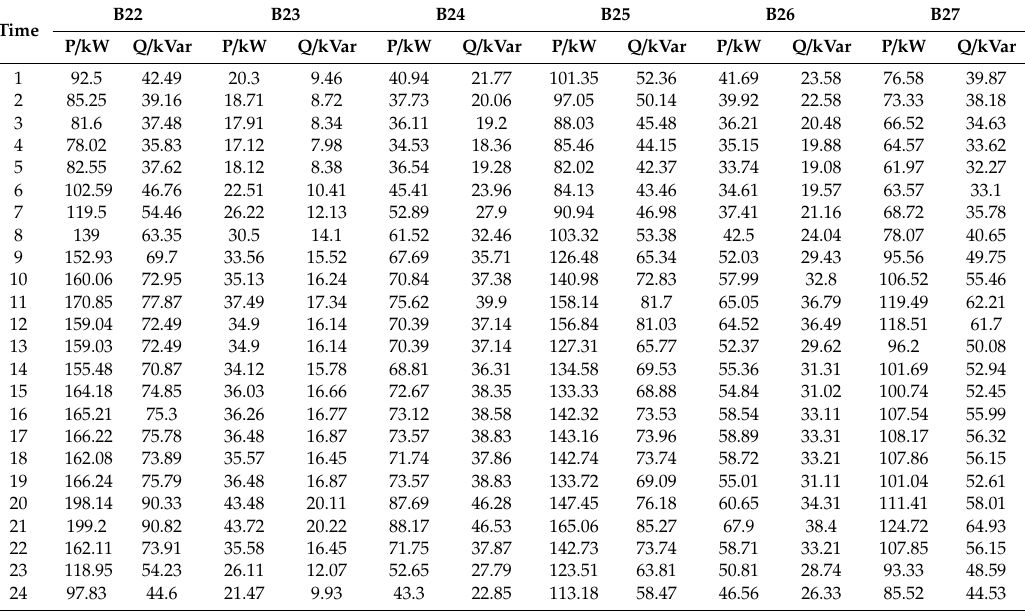
Table A4. The bus load at di ff erent time of nodes